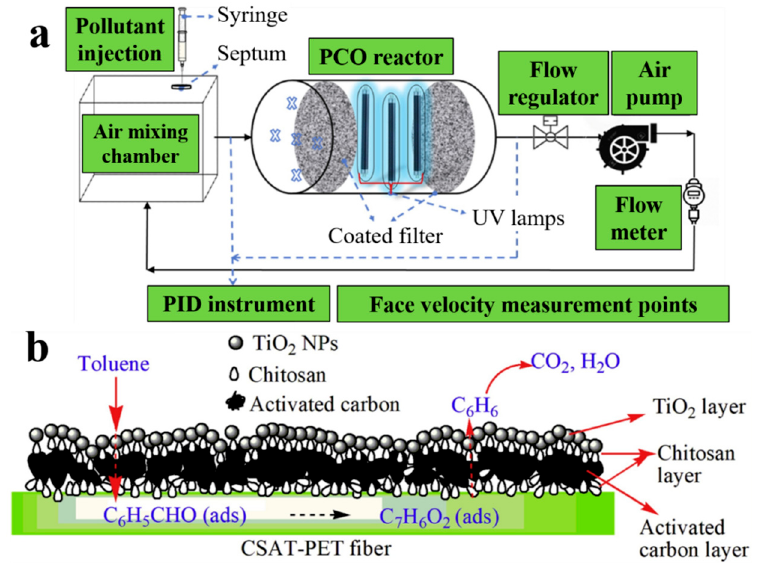
Figure 5. Schematic representation of the TiO 2 /ACF-based photoreactor, which is made of acrylic and consisted of an annular PCO reactor, air mixing chamber, and air pump. ( a ) and VOCs removal mechanism ( b ) [96]. Copyright 2019, Elsevier.